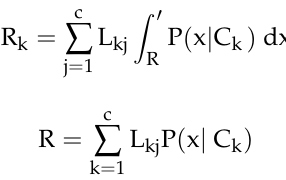
Table 7. The AdaBoost (DT) confusion matrix with a low misclassification rate.